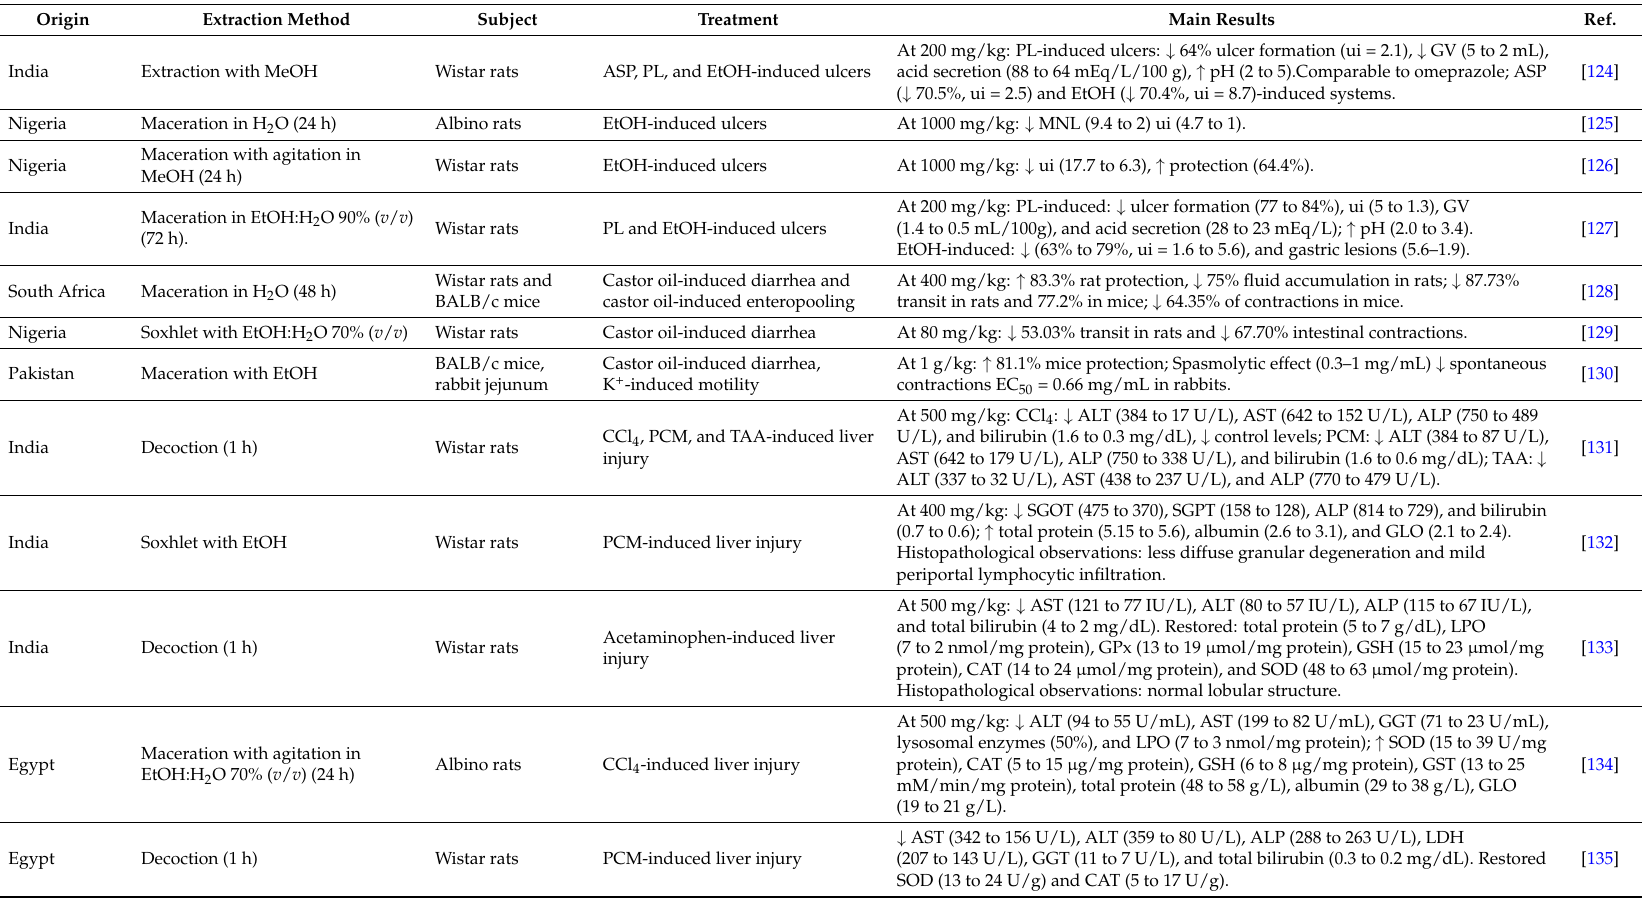
Table 9. In vivo assays for digestive system related